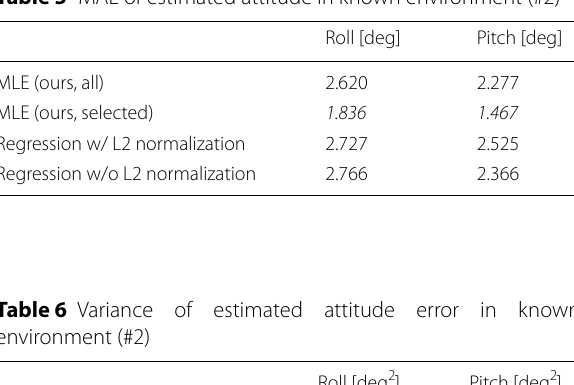
Table 5 MAE of estimated attitude in known environment (#2)